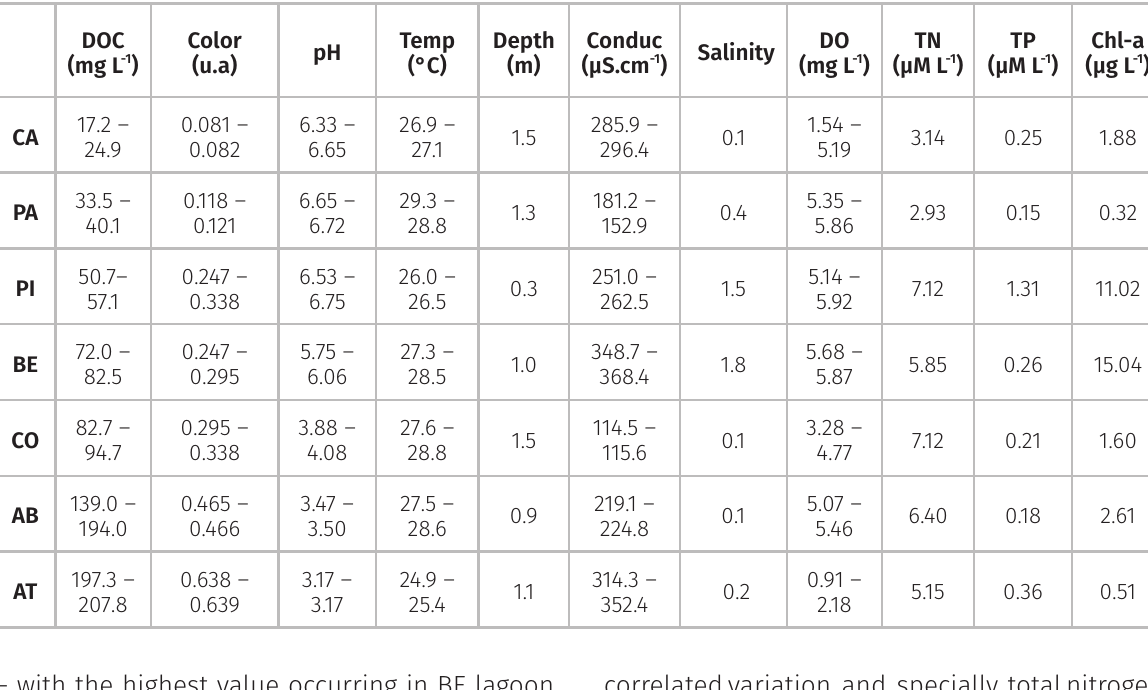
Table I. Physical and chemical parameters measured in all sampled environments along the proposed humic substances gradient. Range of variation of physical and chemical variables obtained in the field between actual sampling and 7 days prior to actual sampling is portrayed for DOC, Color, pH, Temp, Depth, Conduc, Salinity and DO. CA = Cabiúnas; PA = Paulista; PI= Pitanga; BE= Bezerra; CO= Comprida; AB= Amarra-boi, AT= Atoleiro; DOC = dissolved organic carbon; Color= water color; Temp = water temperature; Conduct = conductivity; DO = dissolved oxygen; TN = total nitrogen; TP = total phosphorous, and CHL-a = chlorophyll